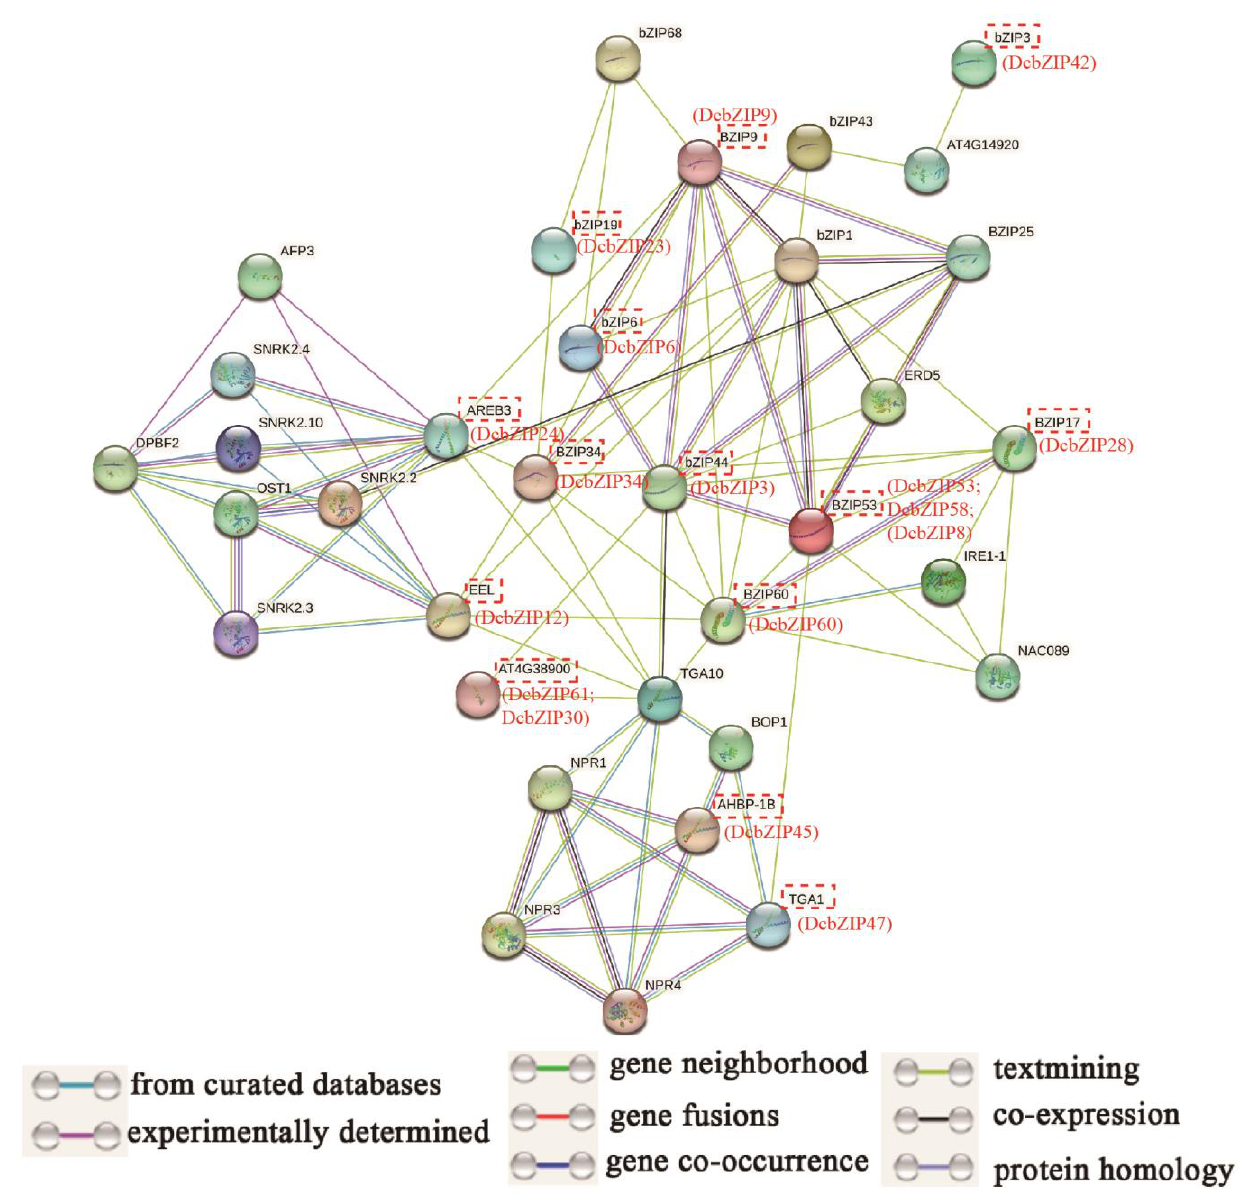
Figure 7. Interaction networks of the DcbZIPs in D. catenatum and their orthologs in Arabidopsis . The network was predicted by STRING. The DcbZIP proteins were shown in the red font below with the Arabidopsis orthologs in the red dashed box. Empty nodes represent proteins with unknown 3D structures. Filled nodes represent known or predicted 3D structures. Light blue lines and rose lines represent known interactions. Green, orange and blue lines represent predicted interactions. Cyan lines represent text mining, black lines represent co-expression and light purple lines represent protein homology.